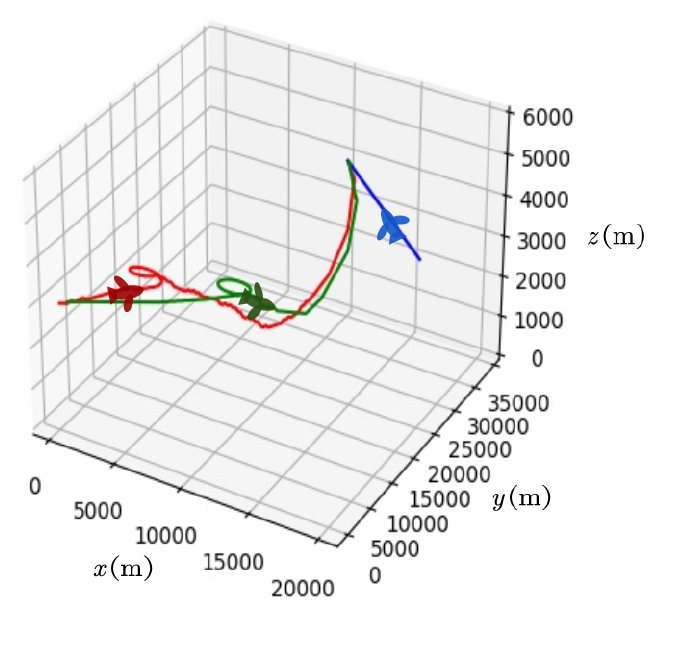
Figure 5. Combat result.